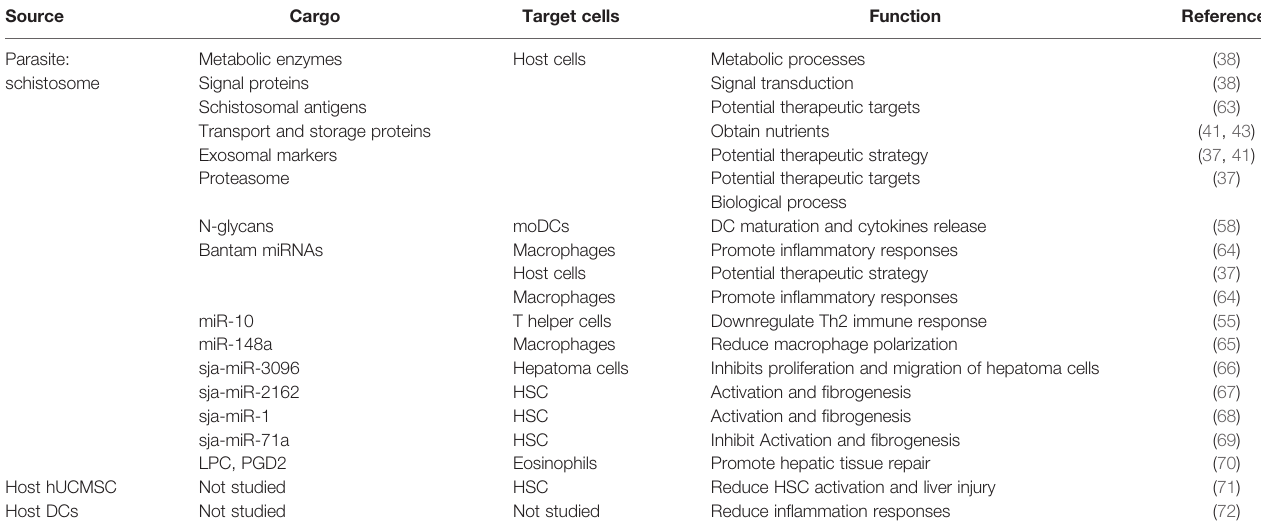
TABLE 1 | Functions of the substances of host- and parasite-derived exosomes in schistosomiasis.